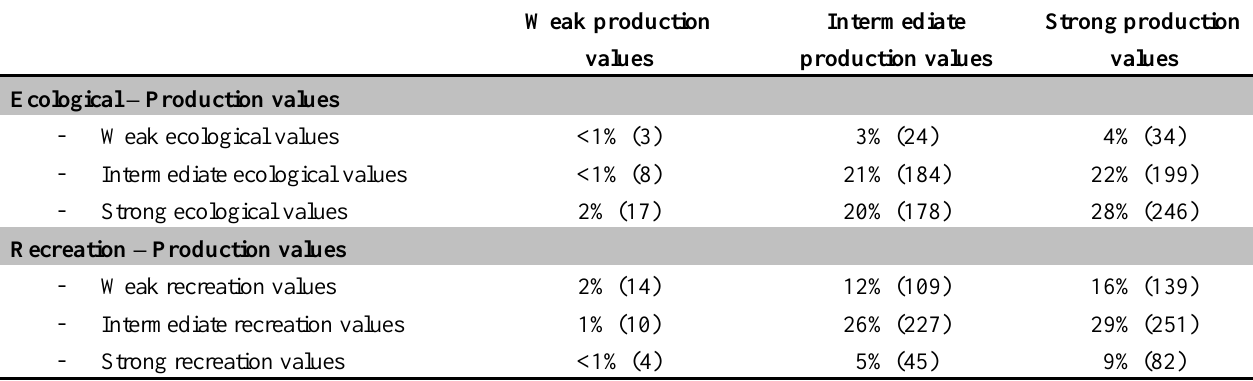
Table 3. Percentage of overall respondents with weak, intermediate, and strong production values cross tabulated with percentage with weak, intermediate, and strong ecological and recreation values.